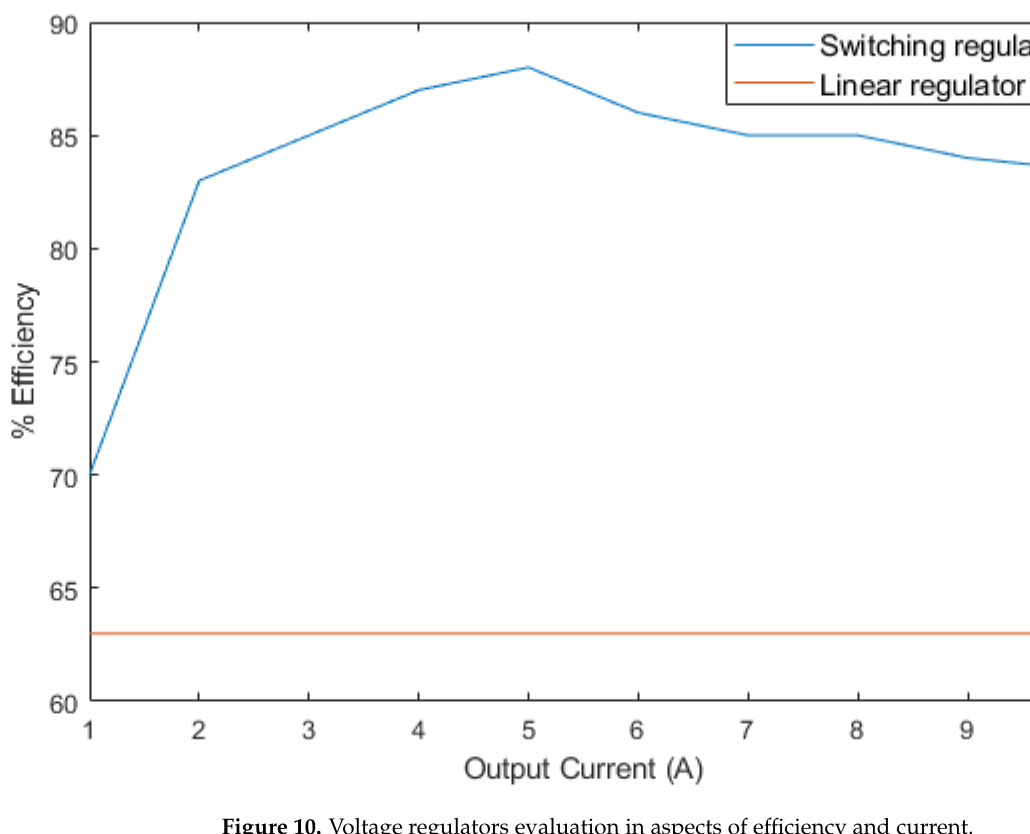
Figure 10. Voltage regulators evaluation in aspects of efficiency and current.